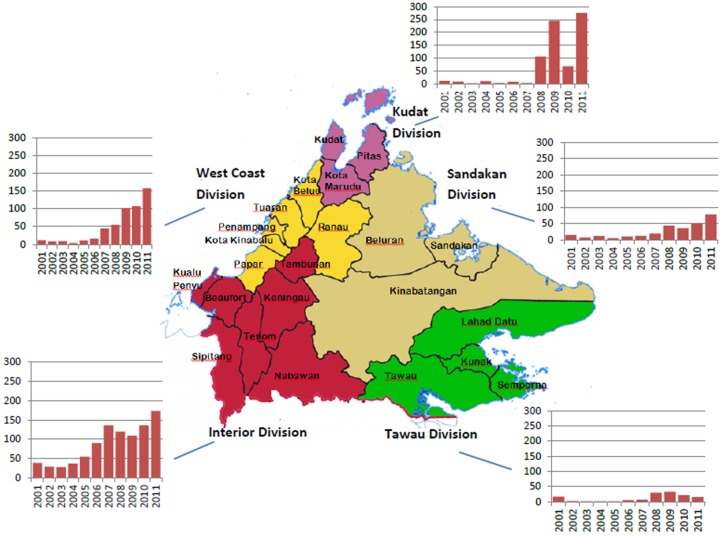

P. malariae/P. knowlesi notifications by division.Map shows districts and divisions of Sabah. Bar graphs show annual P. malariae/P. knowlesi notifications, by division, from 2001–2011. Population of Sabah Divisions in 2010 [37]: Interior 424,524; West Coast 1,011,725; Kudat 192,457; Sandakan 702,207; Tawau 819,955.